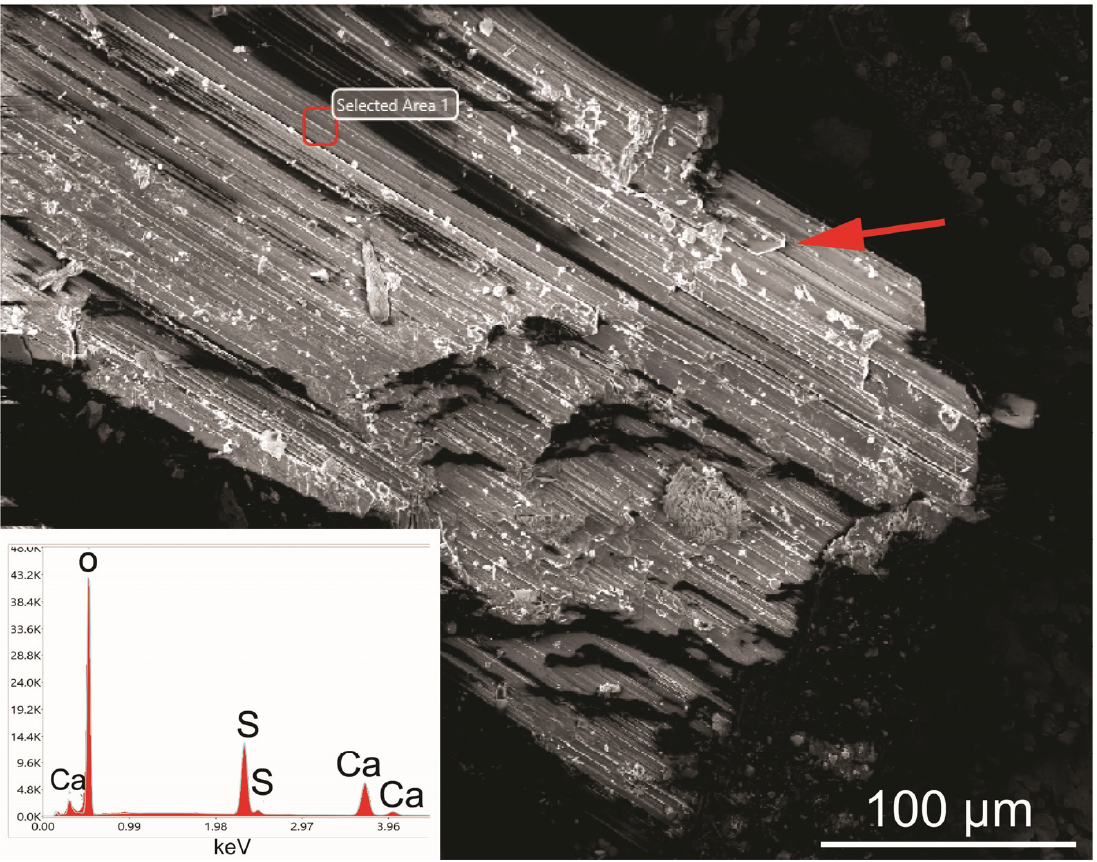
Figure 9. SEM image and corresponding EDS spot analysis (empty red square) of a gypsum crystal from the Mastricarro Barite Mine (Catanzaro, southern Italy). The red arrow indicates the monoclinic character of the gypsum crystals.